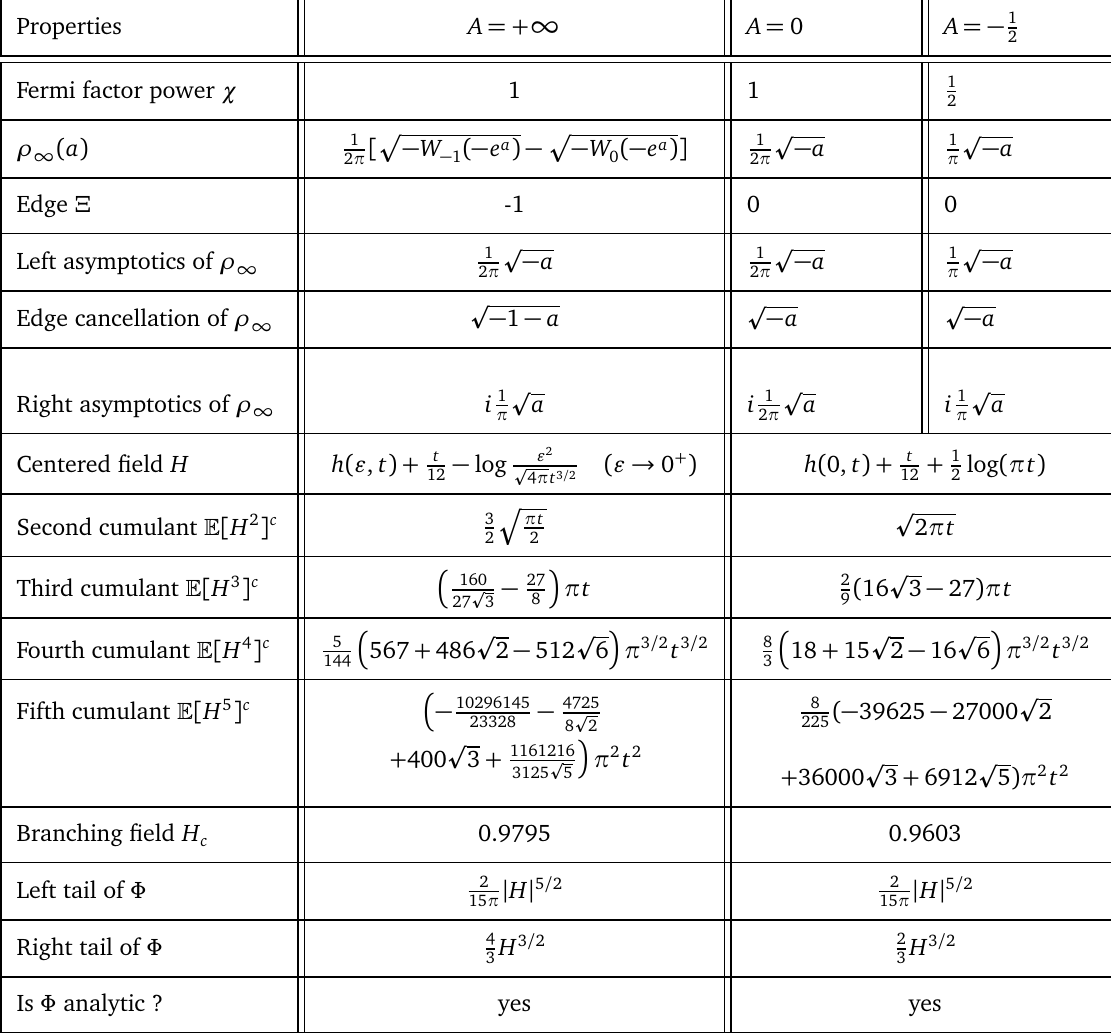
Table 2: Summary of